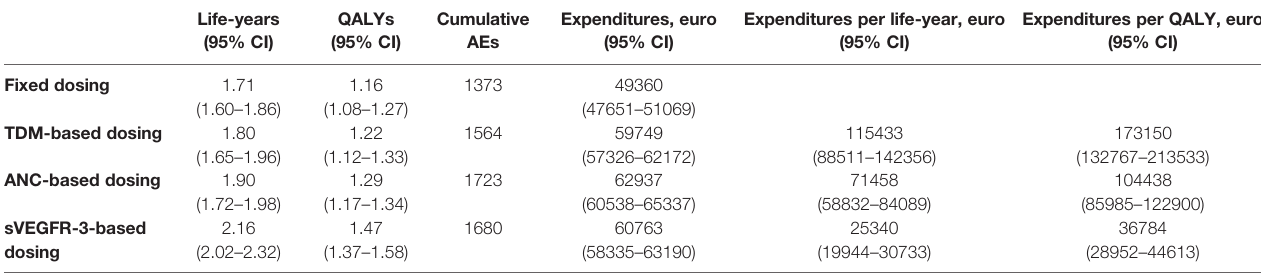
TABLE 2 | Sunitinib biomarker cost-effectiveness analysis, median